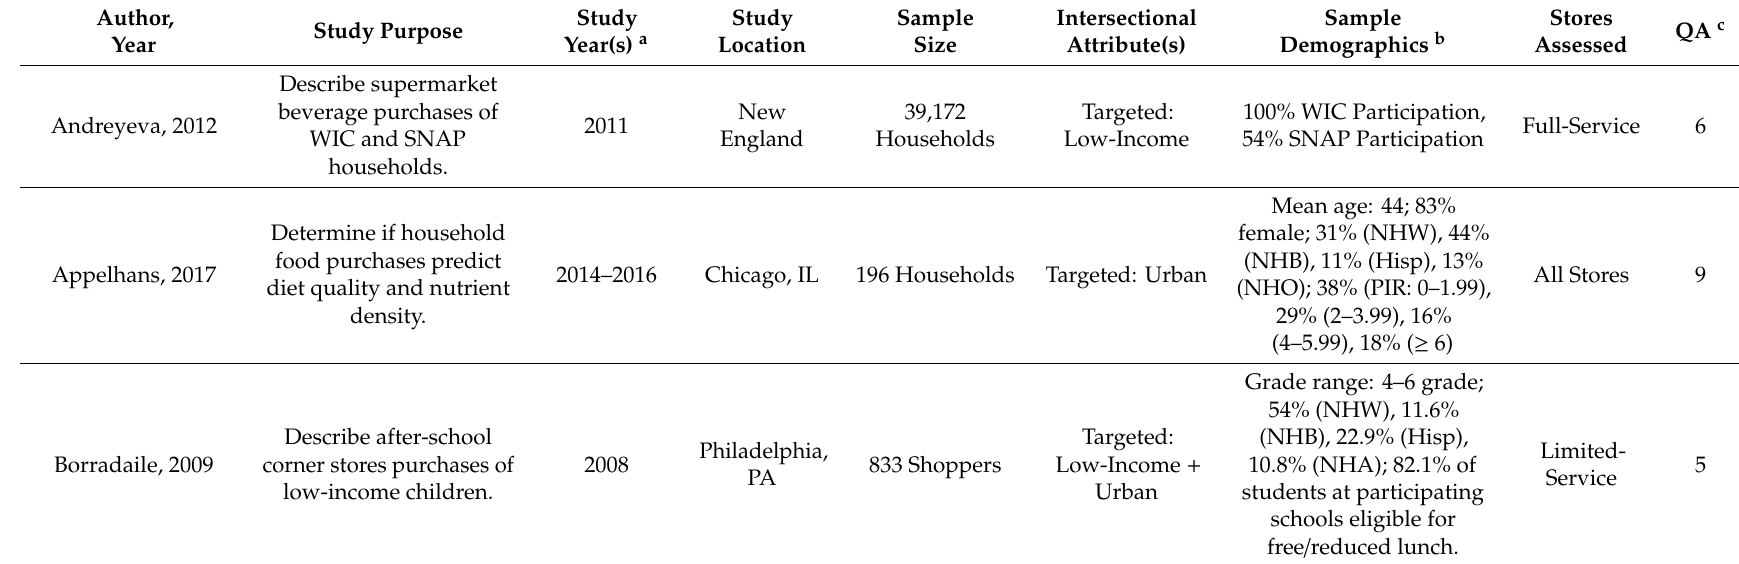
Table 2. Descriptive Characteristics of Included Studies ( n =